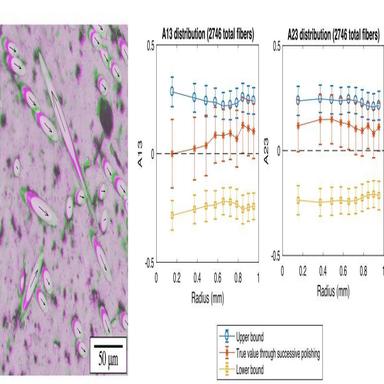
(A) Overlay of optical micrographs showing the reference image (green) and target image (red), with arrows pointing from the centroid on the reference image to the centroid on the target image, as well as plots of the (B) A13 and the (C) A23 components of the Aij tensor, showing the upper bound, the lower bound, and the true value determined through successive polishing and automatic image analysis. (For interpretation of the references to colour in this figure legend, the reader is referred to the Web vers